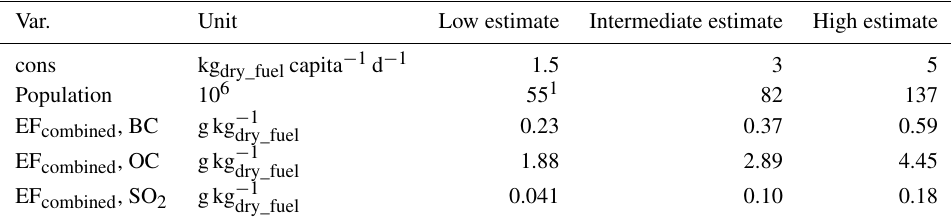
Table 1. The values used to calculate the aerosol emissions from fuel consumption (Eq. 1) for the low, intermediate, and high scenarios. The total population in the study domain is shown instead of the population density (popd, used in the equation) since this is more intuitive.